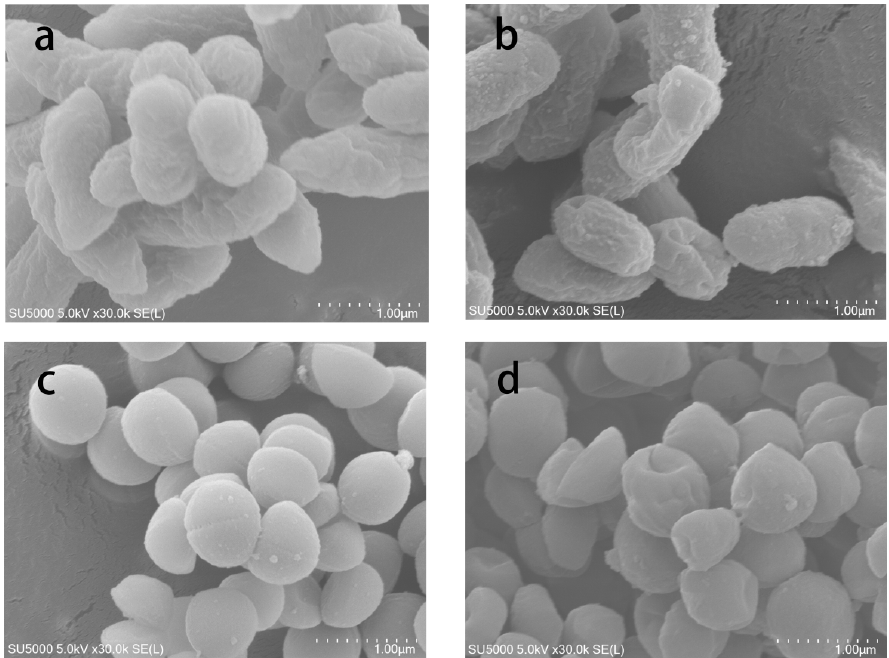
Figure 8. FESEM images of E. coli and S. aureus ( a , c ) untreated and ( b , d ) after functionalized SBA- 15 treatment.